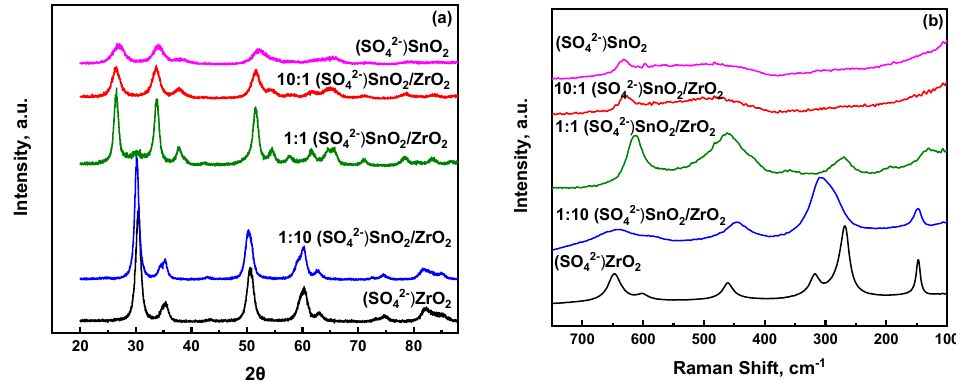
Figure 2. ( a ) X-ray diffraction patterns and ( b ) ambient temperature Raman spectra of sulfated single as well as mixed (SO 42− ) SnO 2 /ZrO 2 oxides.